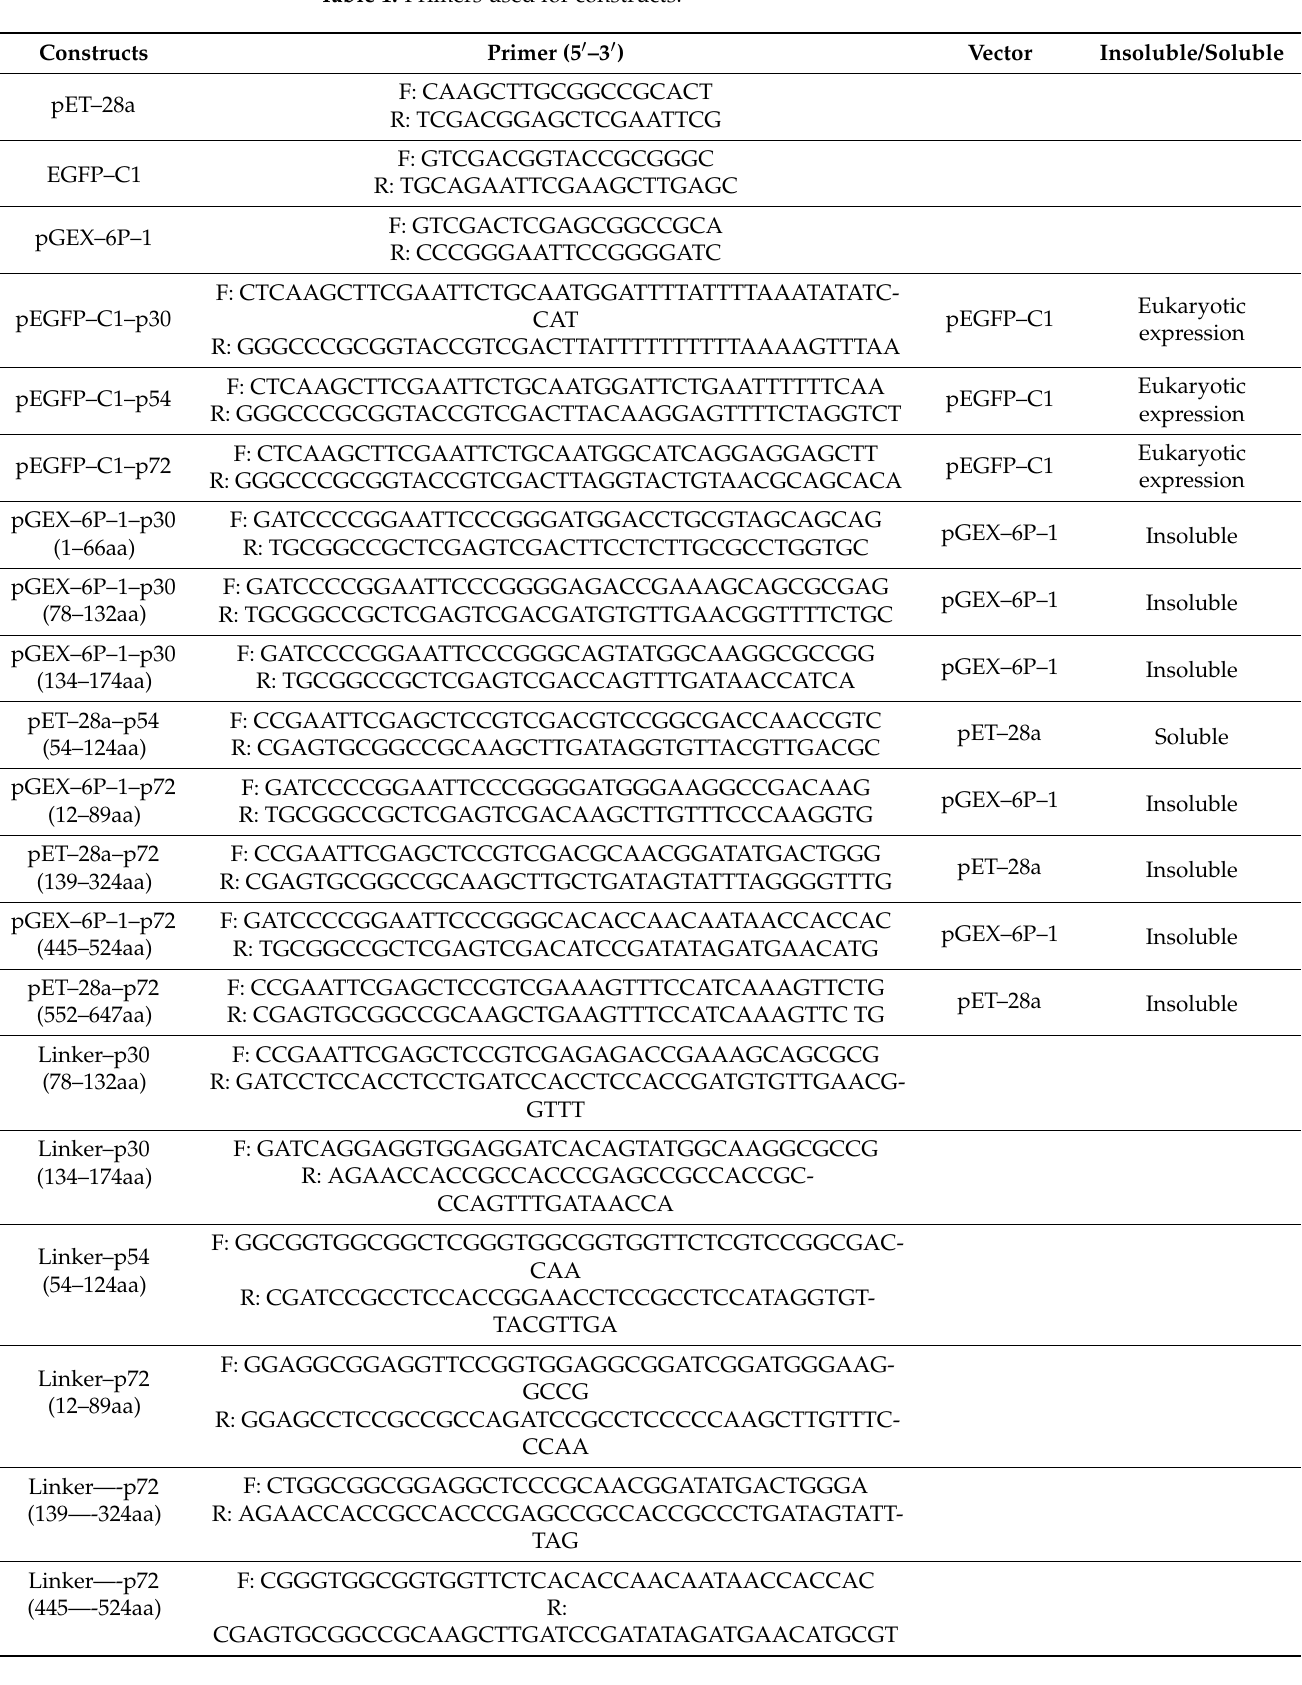
Table 1. Primers used for